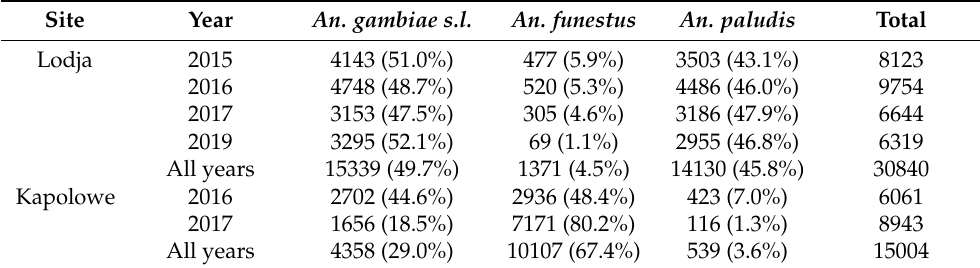
Table 3. Total number and proportion of Anopheles species collected from Lodja (2015–2017 and 2019) and Kapolowe (2016–2017) using human landing catches from eight different houses each month for each